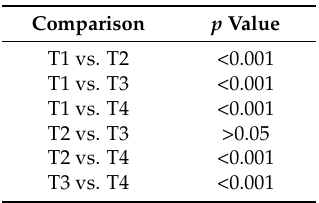
Table 4. CD3 Dunn’s multiple comparison between